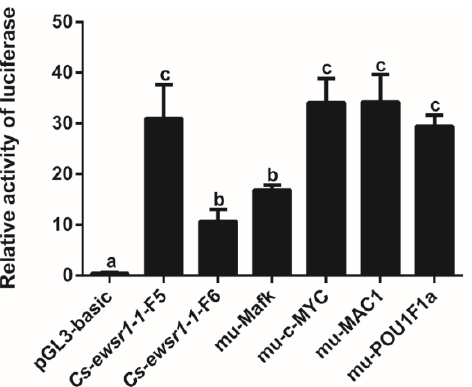
Figure 7. Fluorescence activity of the mutated transcription factor binding sites in Cs-ewsr1-w promoter compared with that of Cs-ewsr1-w promoter region with different deletion. Different letters represent significant differences among species ( p < 0.05).